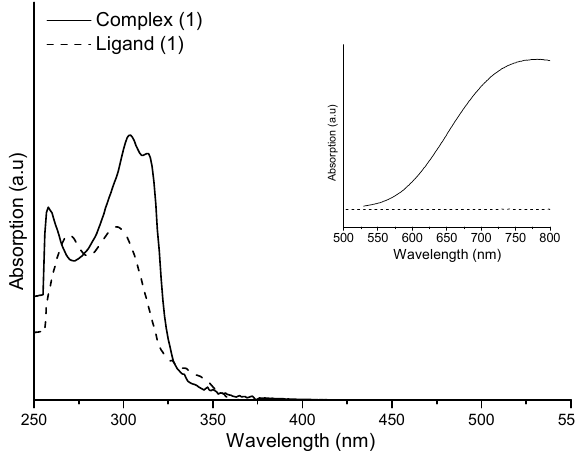
Figure 2. Absorption spectra of the complex 1 and free ligand measured at 298 K using the same concentration (1 × 10 − 5 M H 2 O/DMSO (95/05%).